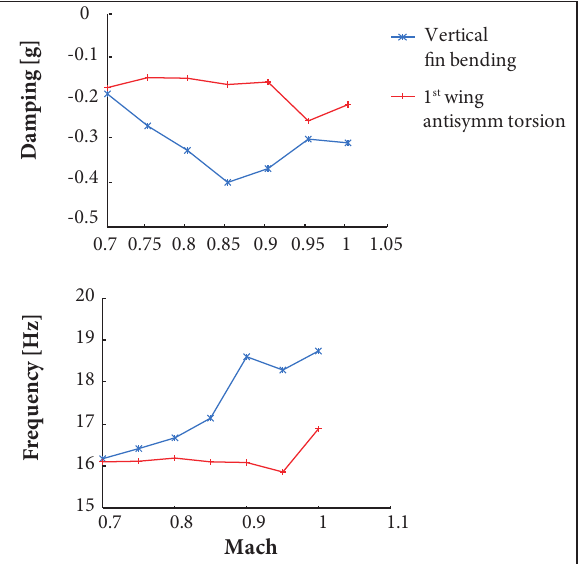
Figure 9. Matched point flutter